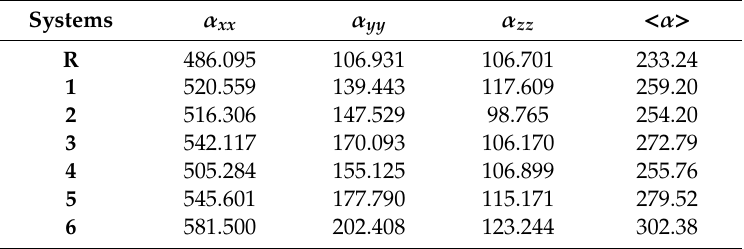
Table 3. Dipole polarizabilities and major contributing tensors (a.u.) of R and 1 – 6 in the gas phase at the CAM-B3LYP / 6-31G(d,p) level of